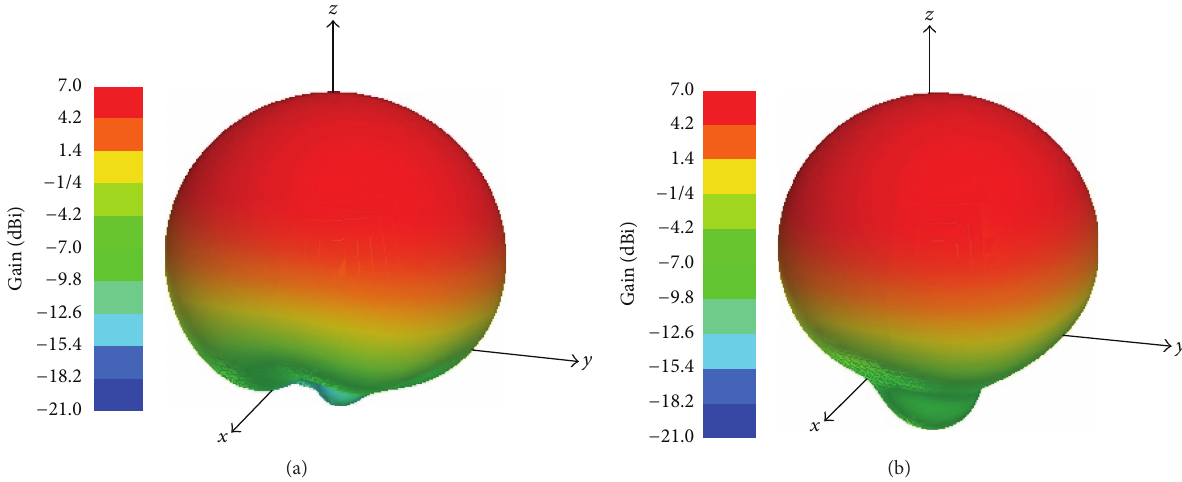
Figure 9: Simulated 3D total-gain pattern of the cavity-backed asymmetrical four-arm curl antenna with 𝐻 𝑐 = 30 mm: (a) GPS L1 and (b) GPS L2